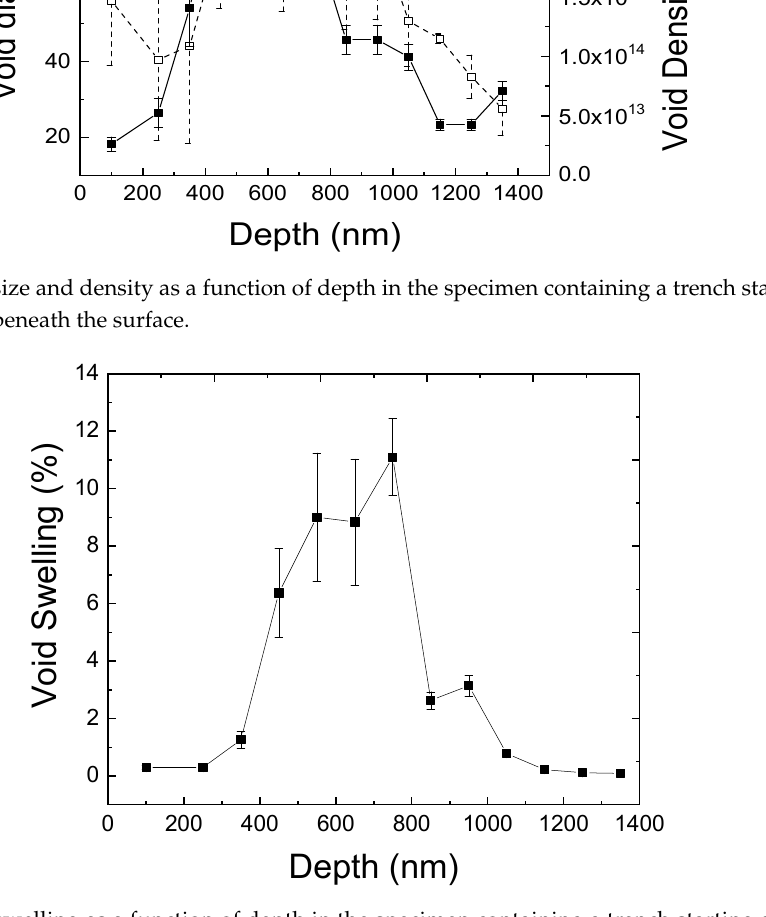
Figure 5. Void swelling as a function of depth in the specimen containing a trench starting at about ~1.7 µ m beneath the surface.